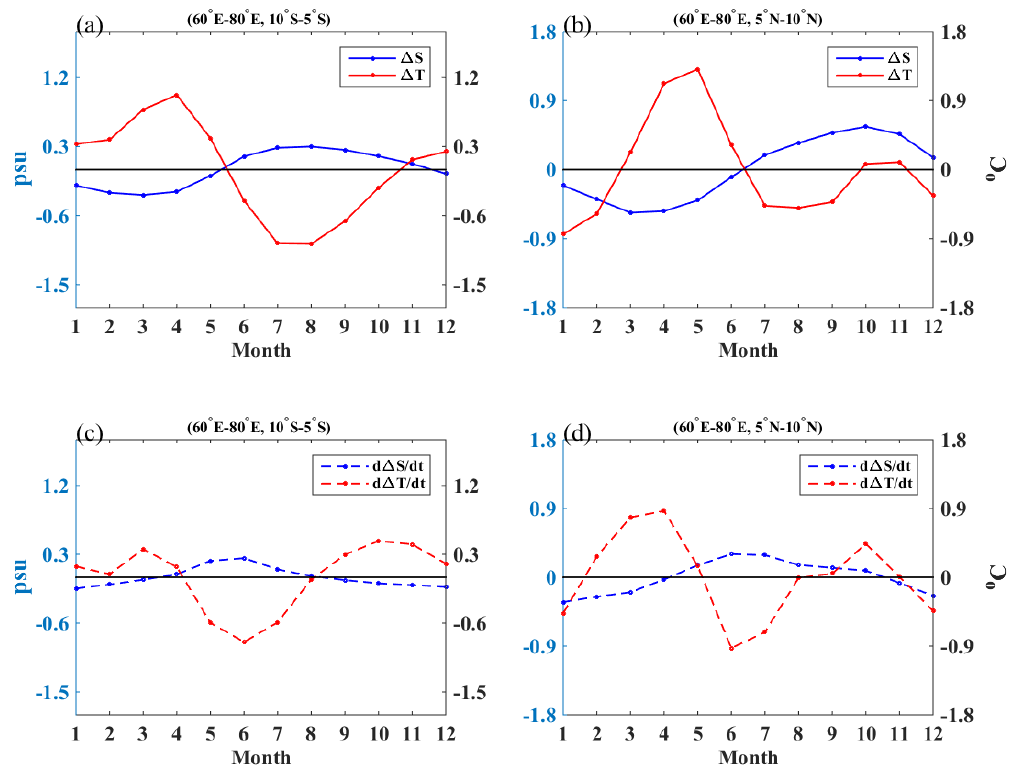
Figure 3. Seasonal variability and tendency for both SSSA (obtained from Argo, in blue) and SSTA (obtained from NOAA; in red) in the areas [( a , c ); 60° E – 80° E, 10° S – 5° S] and [( b , d ); 60° E – 80° E, 5° N – 10° N] for 2005 to 2014. Unit: psu; ℃ .